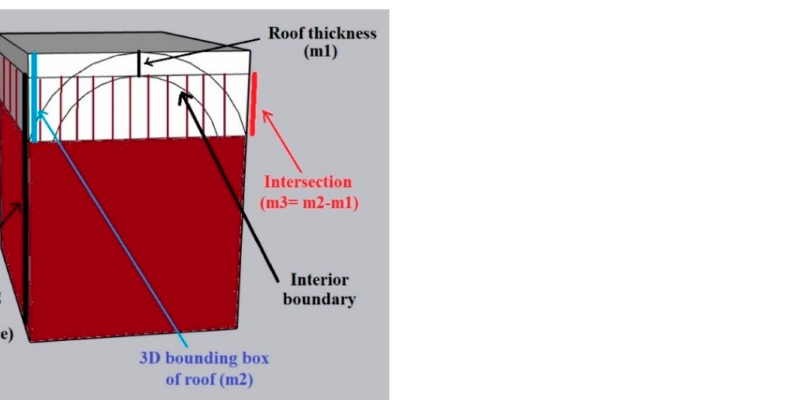
Figure 6. Using (thickness of intersection between 3D bounding box of roof and 3D bounding box of legal space) for identifying an Interior boundary (a curved roof).